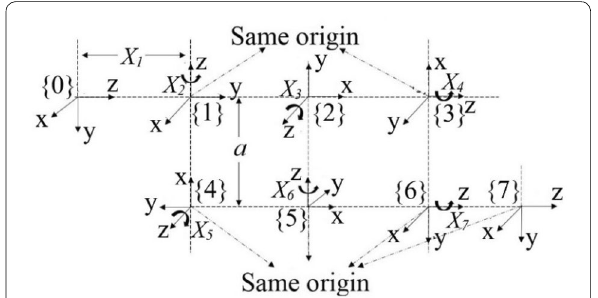
Figure 3 DH frame assignment for one leg of the 3-PRUS manipulator